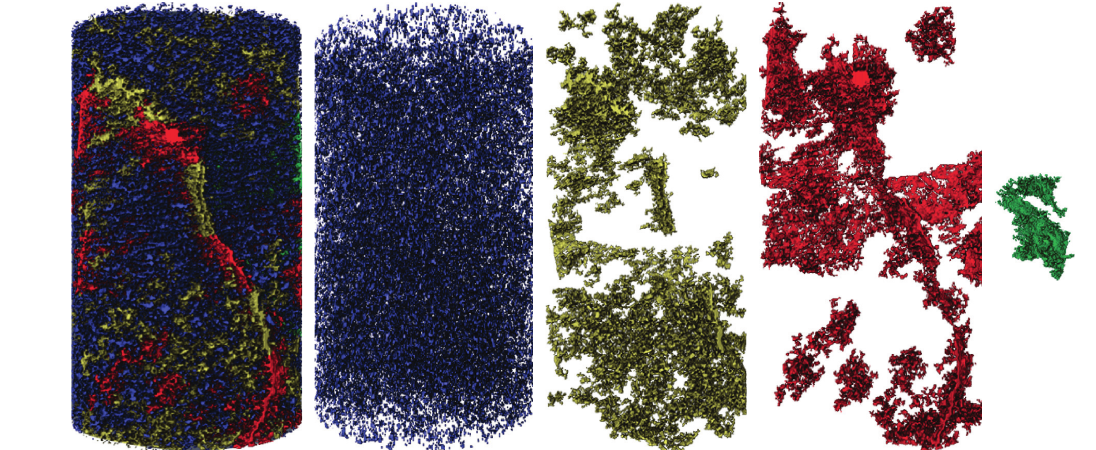
Figure 11: Spatial distribution of the pore structure of sample F-S-2.